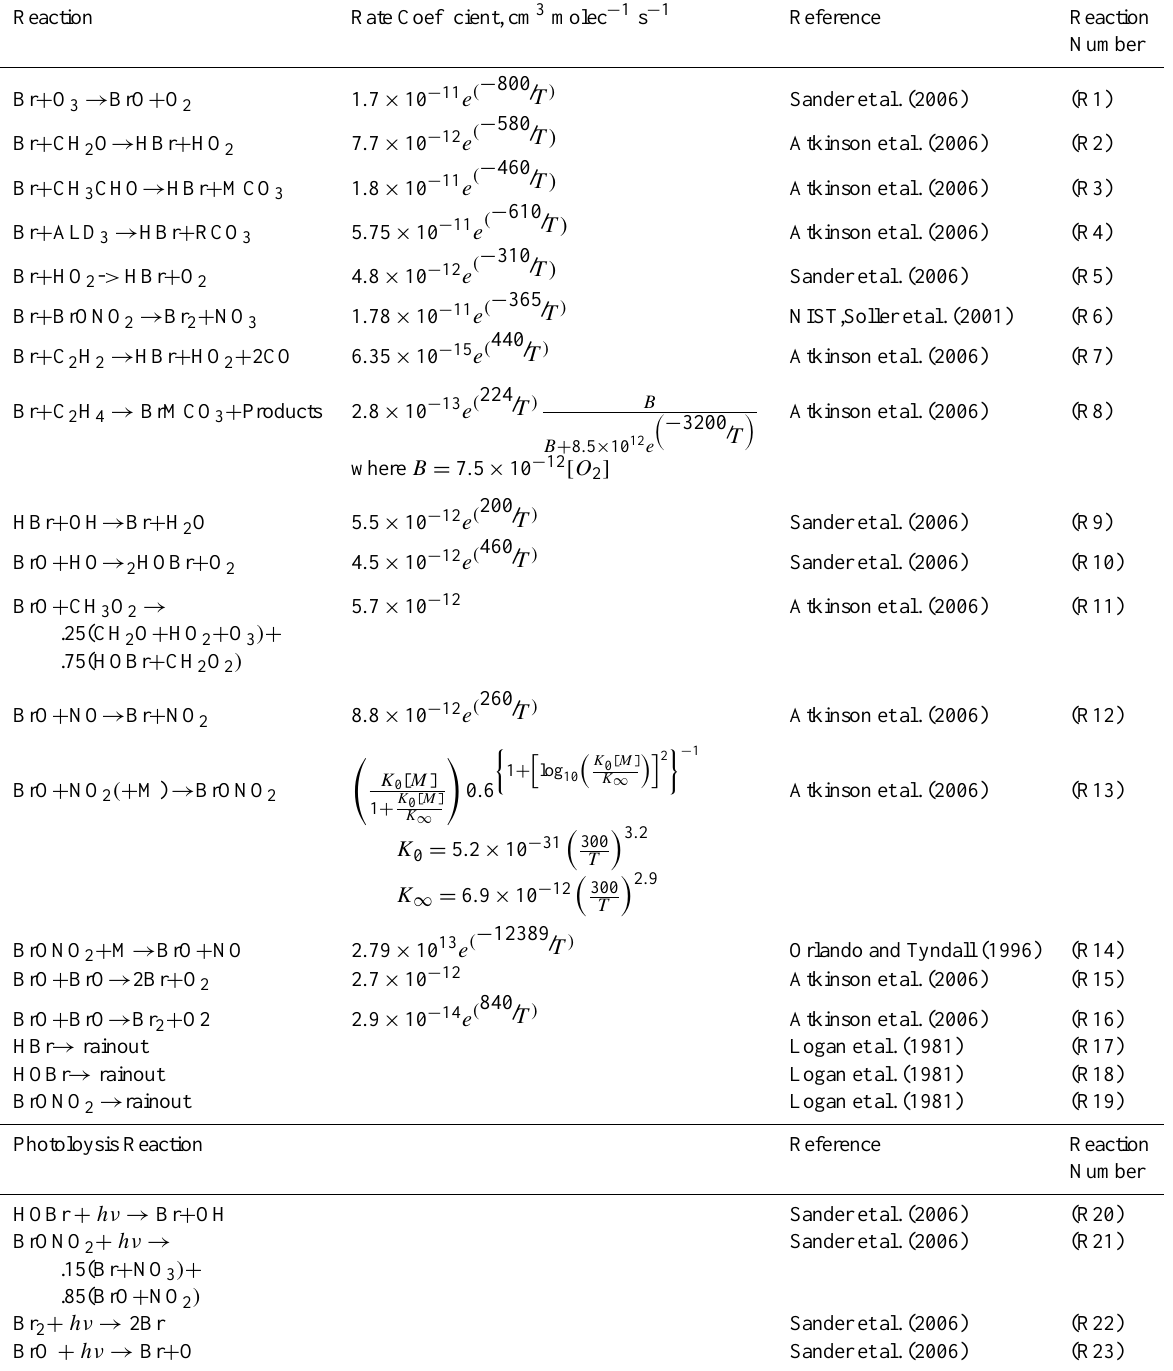
Table 1. Bromine reactions included in the model.